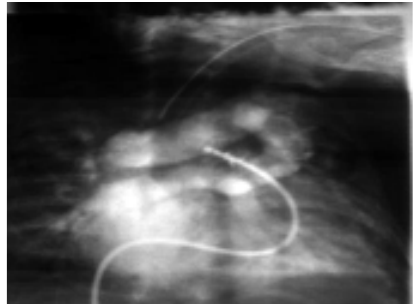
Fig. 1 – Rupture by balloon of the cor triatriatum membrane